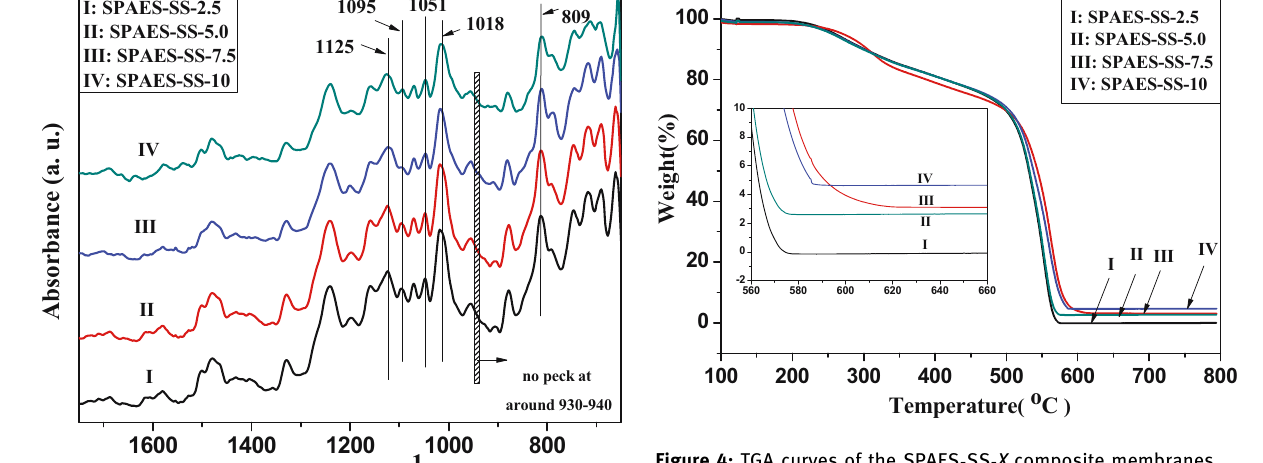
Figure 4: TGA curves of the SPAES - SS - X composite membranes in